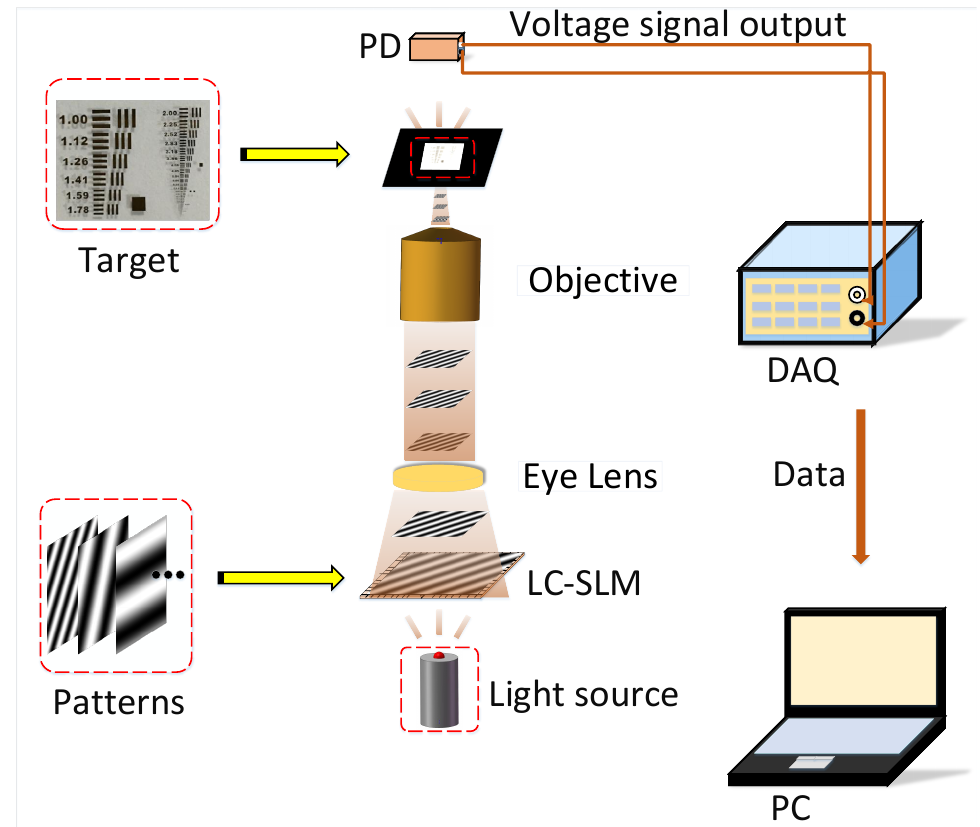
Figure 2. Experimental principle of transmissive single-pixel microscopic imaging. Target, USAF- 1951 resolution test